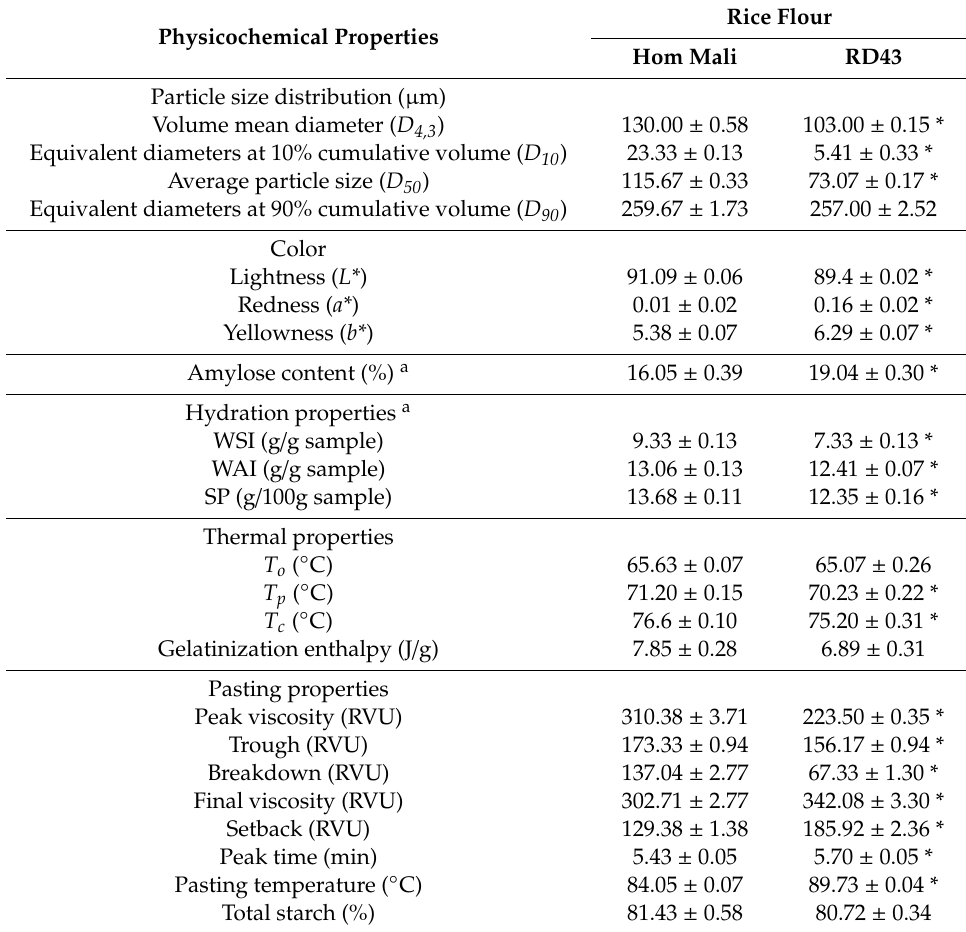
Table 1. The particle size distribution, color profile, and amylose content, as well as hydration, thermal and pasting properties of Hom Mali and RD43 rice